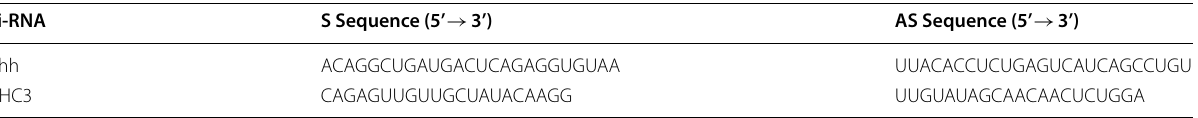
Table 2 List of primers used for siRNA si-RNA S Sequence (5’